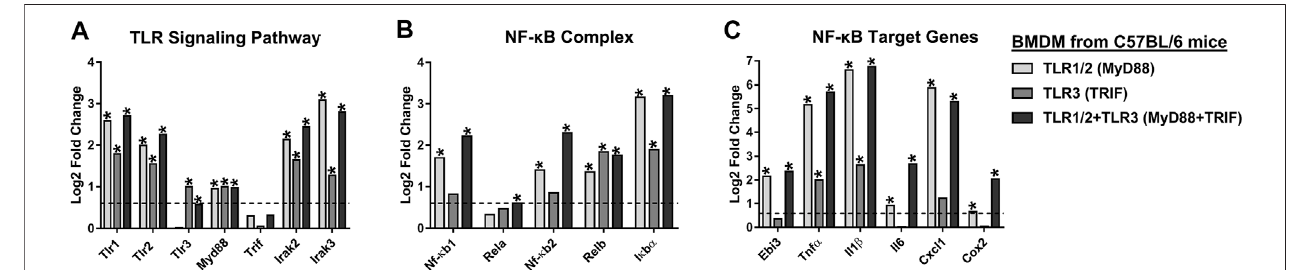
FIGURE 7 | TLR1/2-MyD88, but not TLR3-TRIF signaling, activates NF- κ B-complex and induces EBI3 expression in murine BMDM. We reanalyzed the public MicroArray GSE89962 (GEO) (Lin et al., 2017), obtained from BMDM of C57BL/6 mice stimulated with 10 ng/ml Pam3CSK4 and/or 10 μ g/ml Poly (I:C), for 8 h. Differentiallyexpressed(Log2FC)TLRsignalingcomponents (A) ,NF- κ B-complex (B) ,andNF- κ B-targetgenes (C) .DEGswerede fi nedasgeneswithanFDR < 0.05and |Log2 Fold Change (TLR-treated BMDM/unstimulated BMDM) | > 0.6. Signi fi cant results are de fi ned as p < 0.05 (*). n =